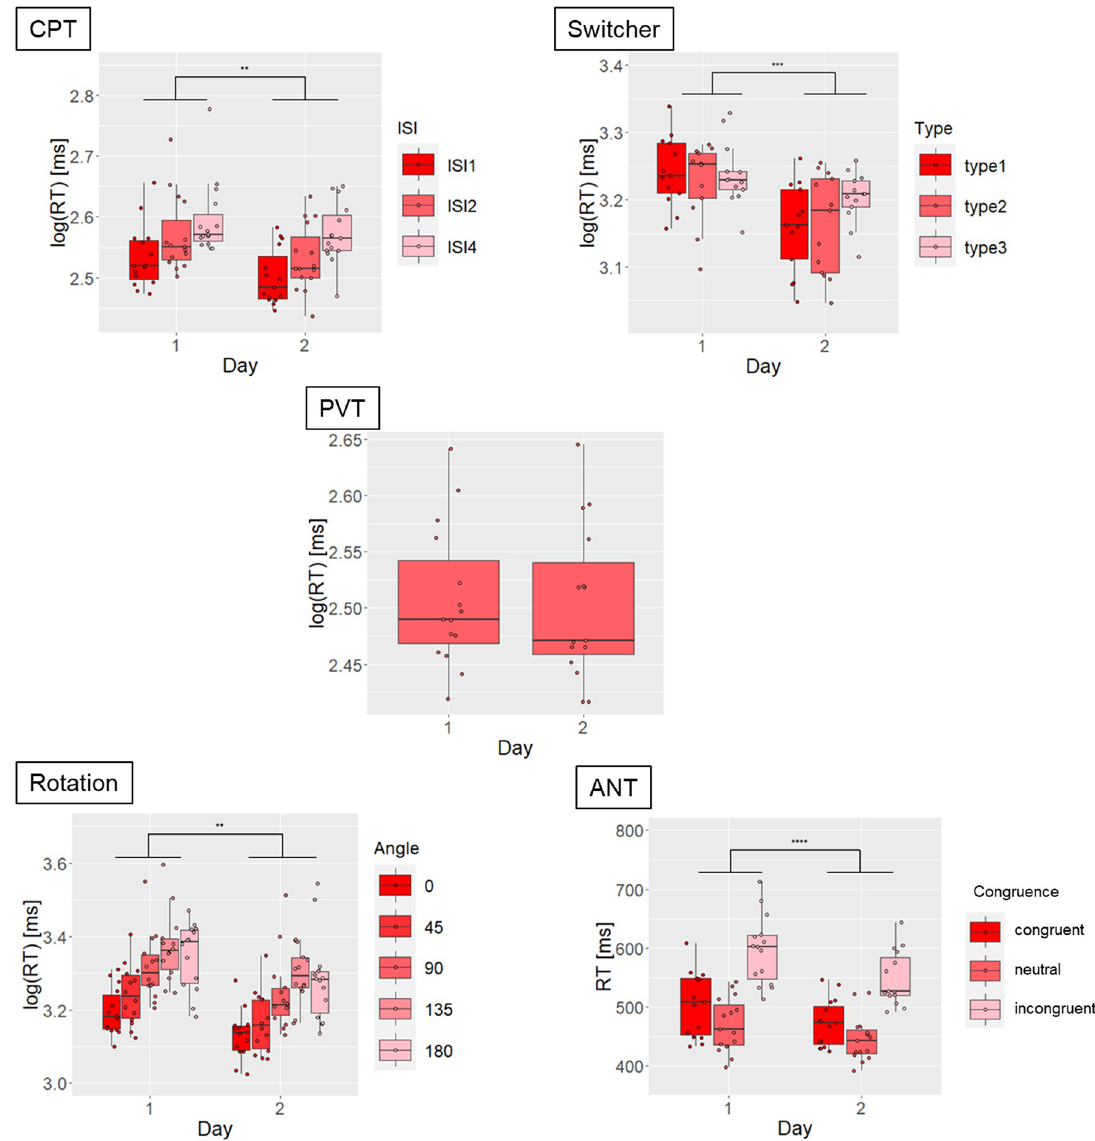
Fig 3. Practice effects are present in reaction times (RT) for all applied tasks, except for PVT. Asterisks represent significant differences ( ���� p < 0.0001, ��� p < 0.001, �� p < 0.01). CPT = Continuous Performance Task; PVT = Psychomotor Vigilance Task; ANT = Attention Network